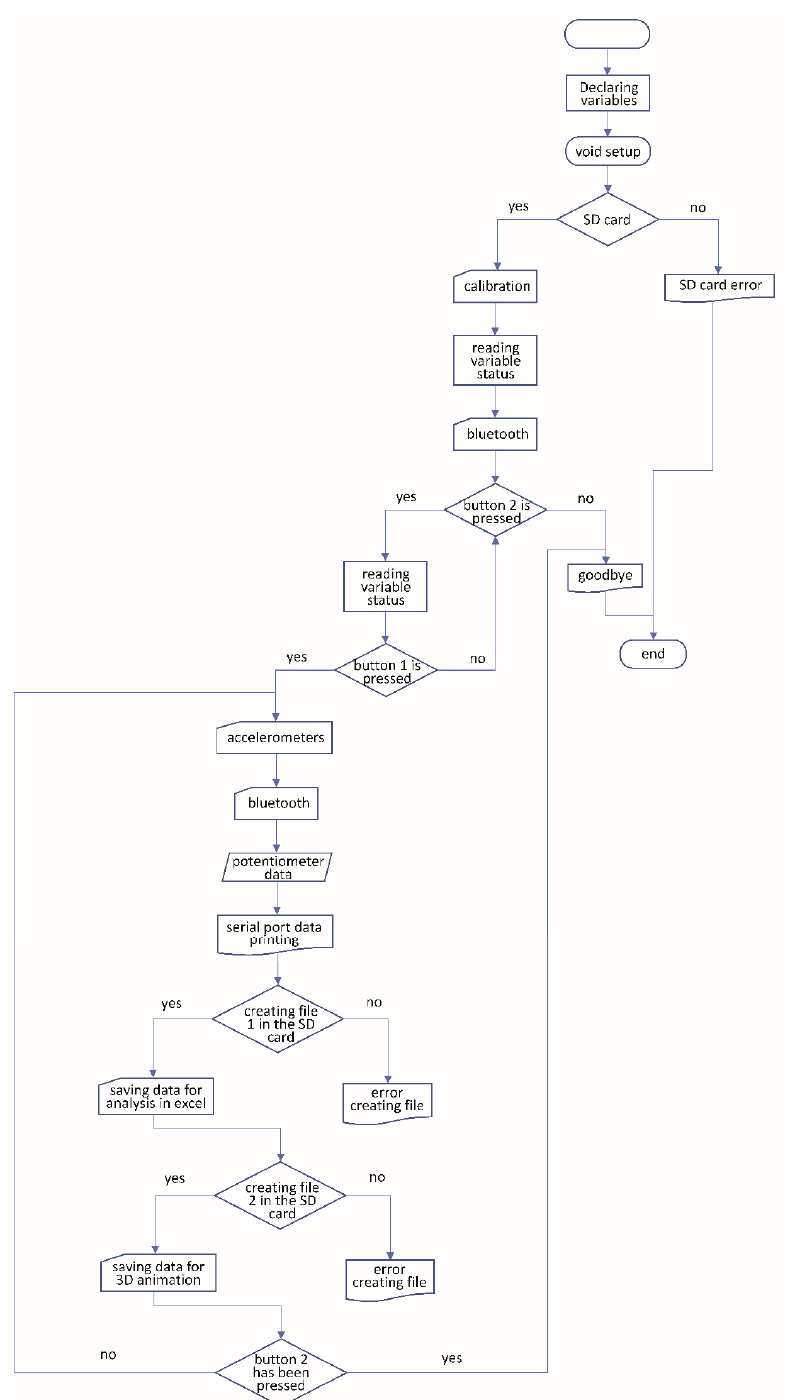
Figure 3. Flow chart of the code developed for Arduino.